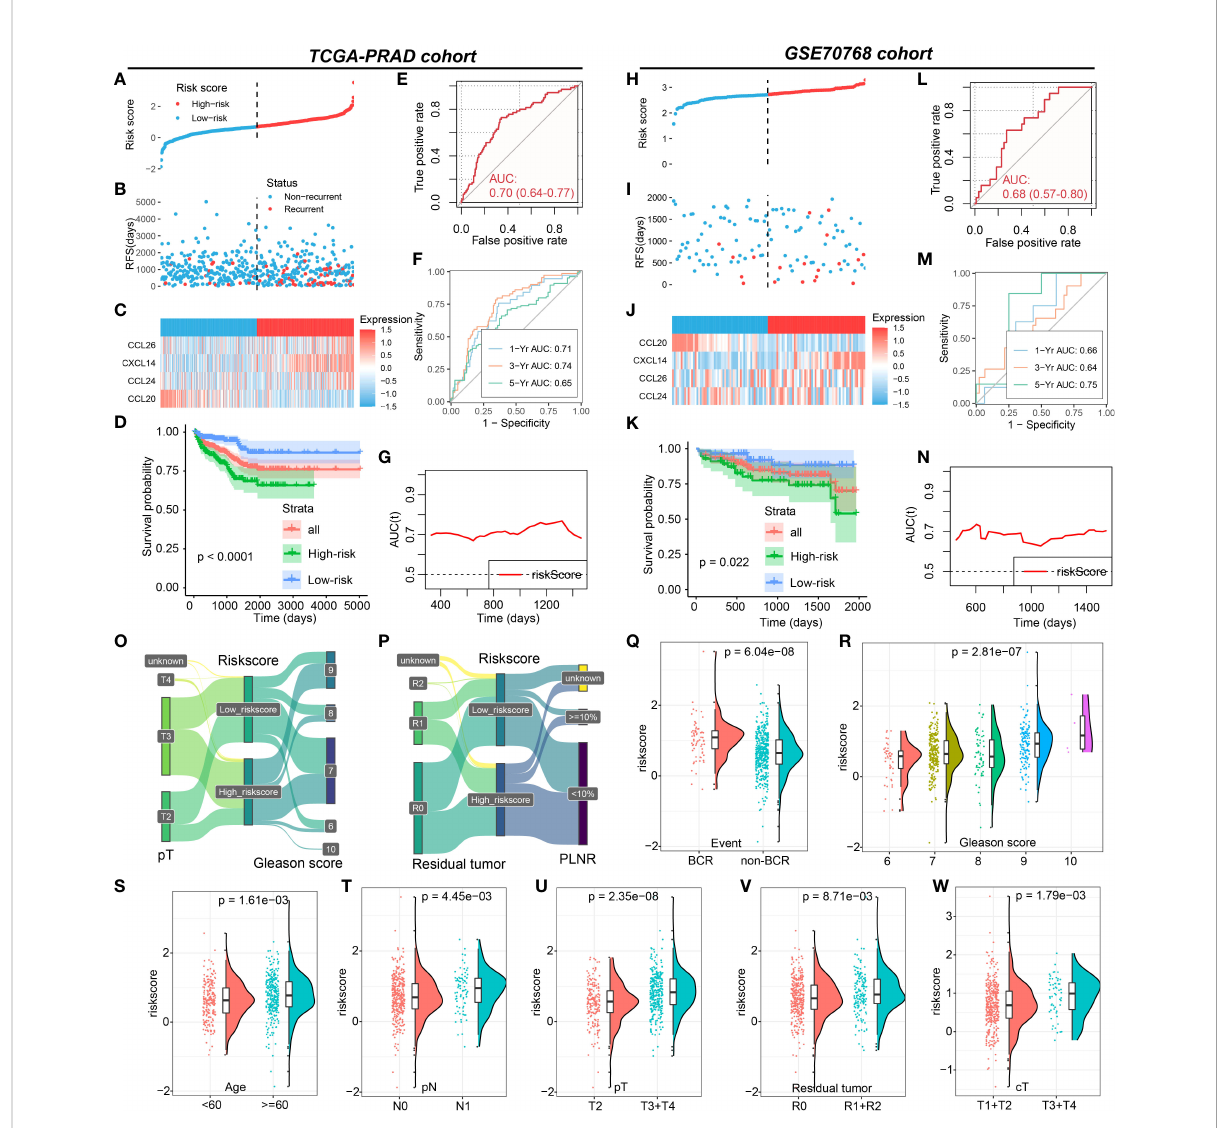
FIGURE 3 Roles of CRPGS in predicting the RFS of PCa. The distribution of the riskscore (A, B) , and the expression of CXCL14, CCL20, CCL24, and CCL26 in high- and low-risk patients in the TCGA-PRAD cohort (C) . Survival analysis between high- and low-risk PCa patients (D) , and the ROC, time-dependent ROC, and AUC curves curve showed the RFS predictivity of CRPGS in the TCGA-PRAD cohort (E – G) . The distribution of the riskscore (H,I) , and the expression of CXCL14, CCL20, CCL24, and CCL26 in high- and low-risk patients in the GSE70768 cohort (J) . Survival analysis between high- and low-risk PCa patients (K) , and the ROC, time-dependent ROC, and AUC curves curve showed the RFS predictivity of CRPGS in the GSE70768 cohort (L – N) . The distribution of T stage, Gleason score, residual tumor, and PLNR in different risk groups by the Sanky plots (O,P) . The distribution of riskscore in PCa patients with different BCR statuses, age, Gleason score, residual tumor, and tumor stages (Q – W)